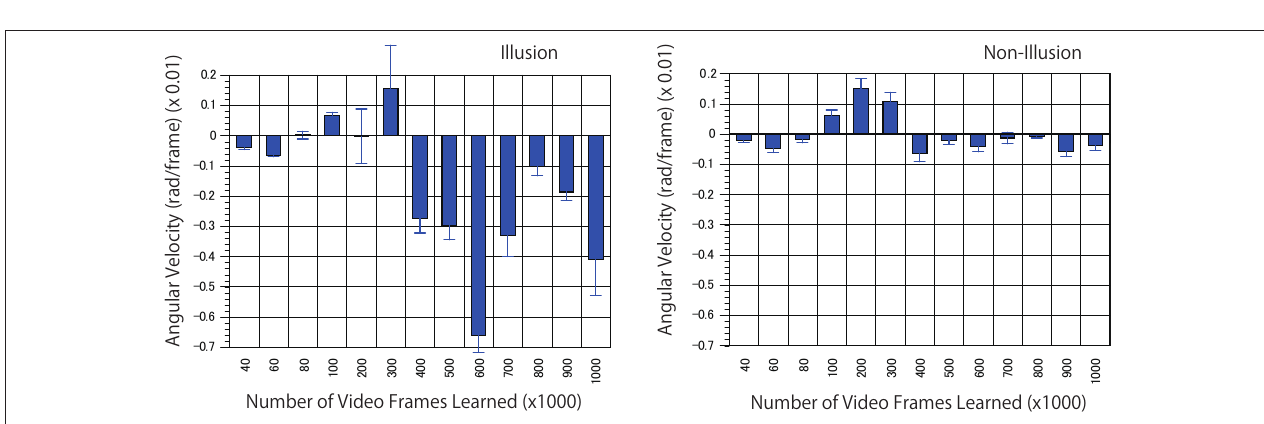
FIGURE 7 | Optical flow vectors detected in the rotating propellers. The vectors were obtained between a pair of the first/second consecutive predictive images (P1/P2) of the rotating propellers. Red bars denote the direction and magnitude of vectors, yellow dots denote the start points of the vectors. To aid visualization, the magnitude of the vectors was amplified 30 times. The vectors were written over the P2 images (width 160, height 120 pixels). A network trained with 500K video frames was used for prediction.